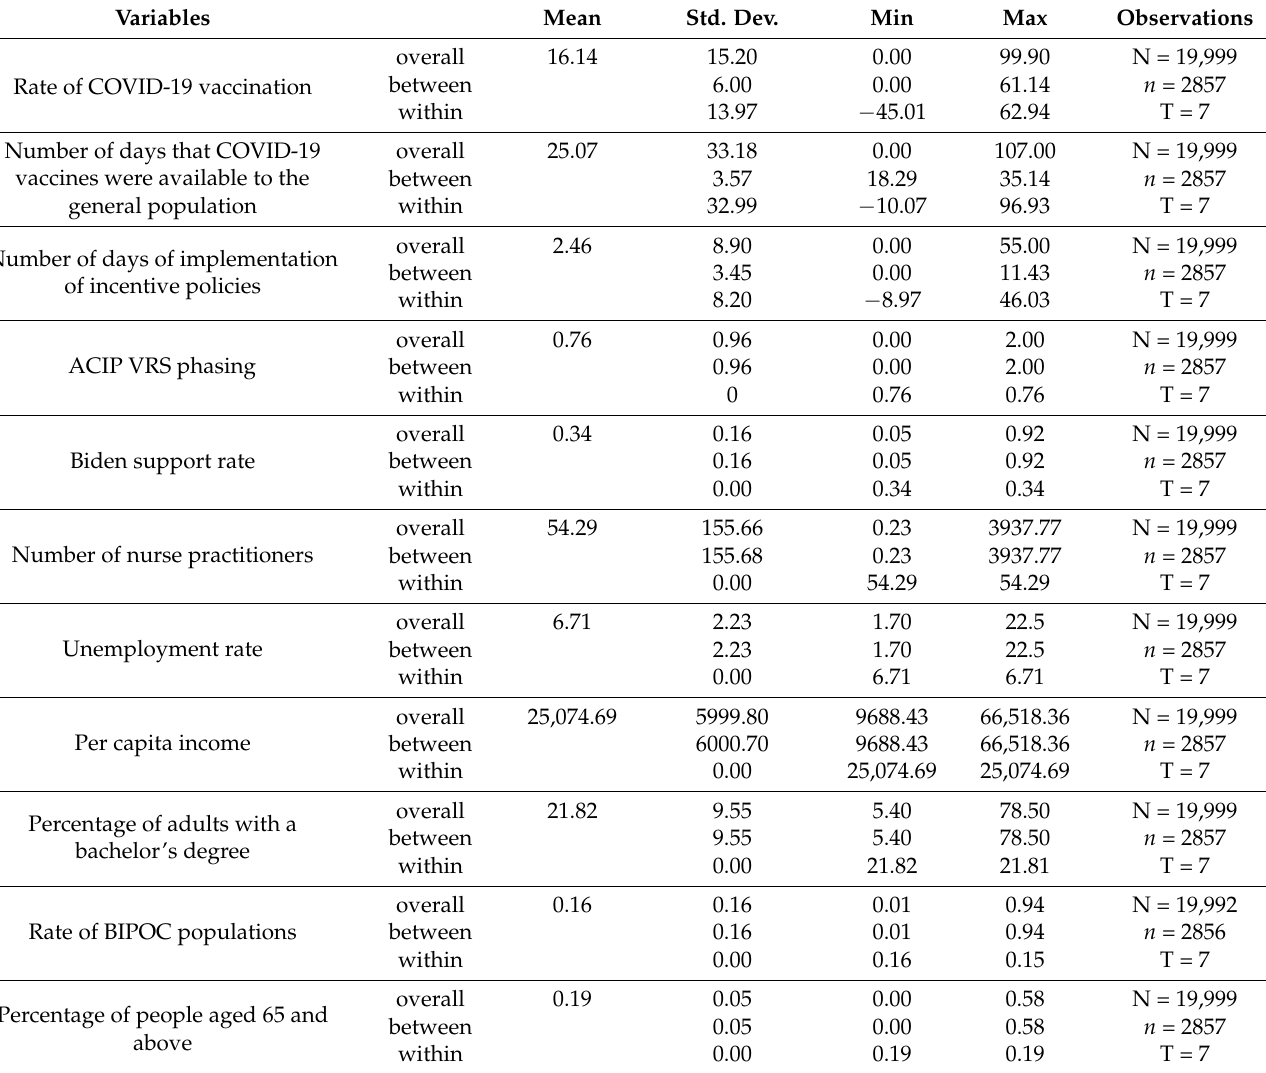
Note: N represents the total observations in the panel data; n indicates the total number of counties in the panel data; T is the total number of periods in this panel data. The dataset is of panel data, and the dependent variable (rate of vaccinated population per county) and key independent variables (the number of days the vaccination was offered to the general population and of incentive policies) vary over both time and individual county. Within variation means the variation over time, given an individual county (if the within variation equals 0, it means that this variable is not time-sensitive in this study period); between variation represents variation across counties; overall variation is the variation over time and across counties. ACIP = CDC Advisory Committee on Immunization Practices; VRS = vaccine recommendations and schedules; BIPOC = Black, Indigenous, and people of